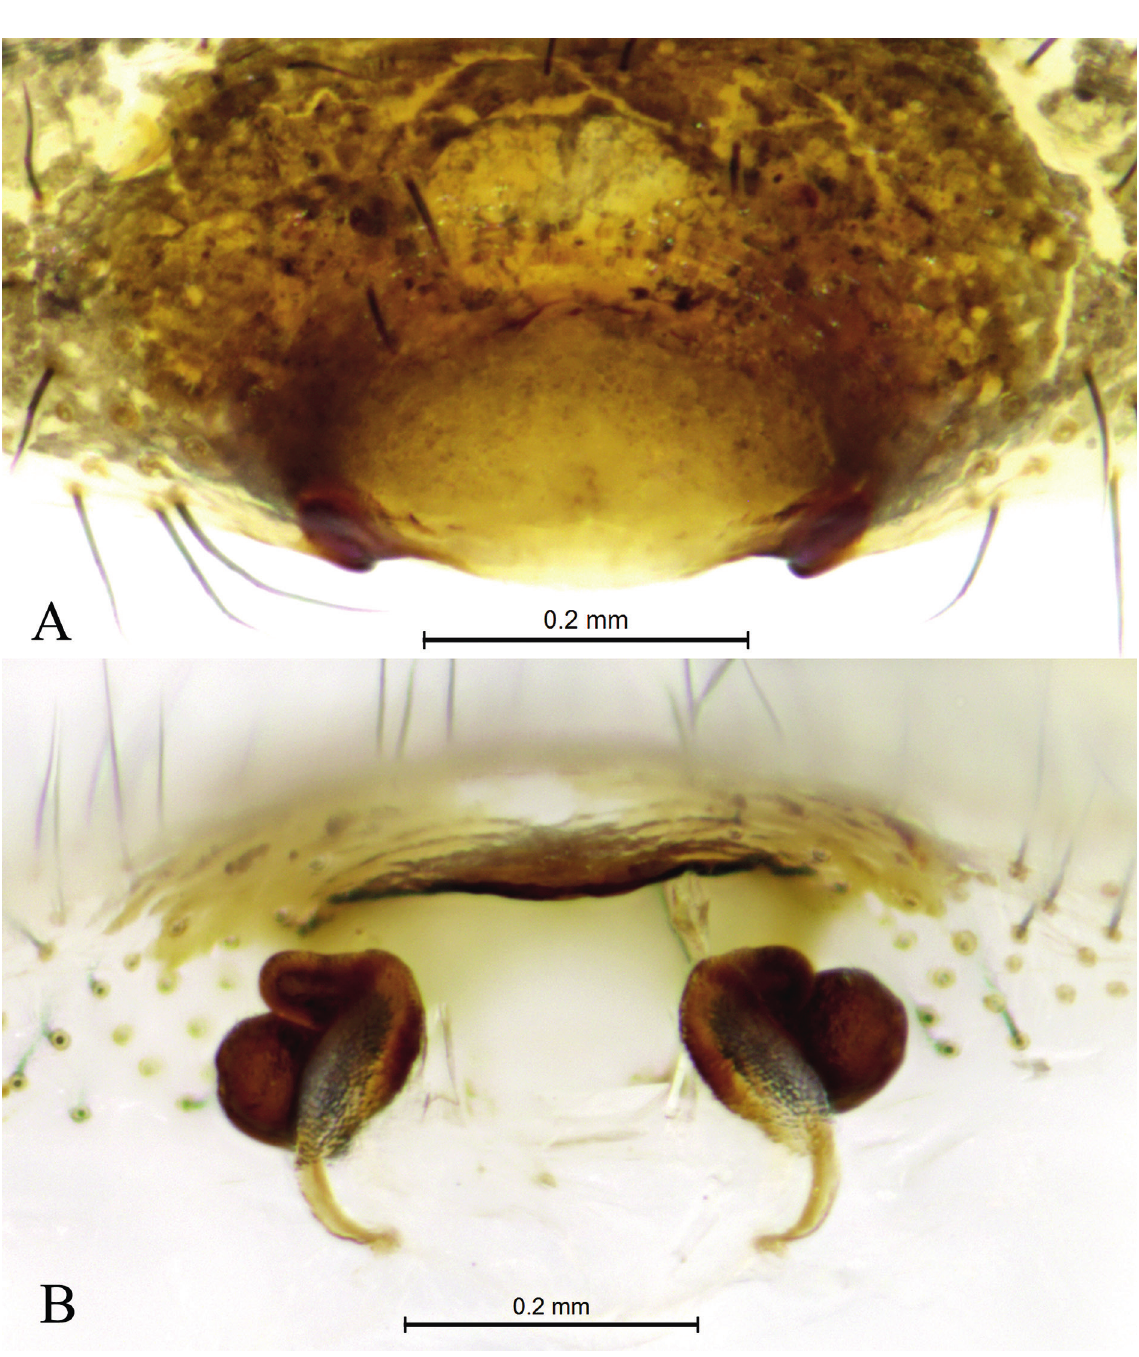
Fig. 4. Meta bowo sp. nov., ♀, paratype (SWUC-T-TEg-02-06). A . Epigyne, ventral view. B . Vulva, dorsal